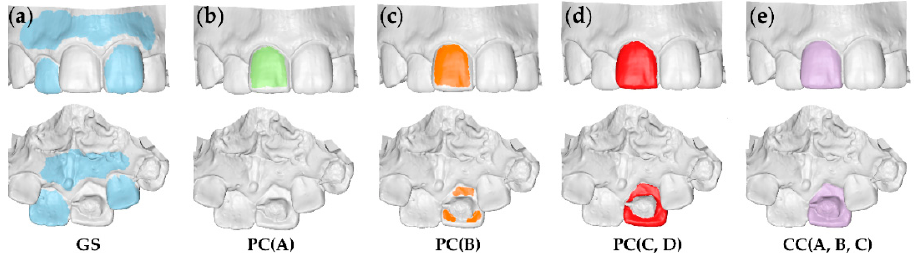
Figure 1. Reference areas used to measure tooth wear at the right maxillary permanent central incisor. ( a ) Gold standard area (GS: blue). ( b – d ) Partial crown areas (PC: green, orange, red). ( e ) Complete crown area (CC: purple). The upper row shows the buccal and the lower row the palatal view. The letters within the parentheses indicate the settings applied for each reference area.